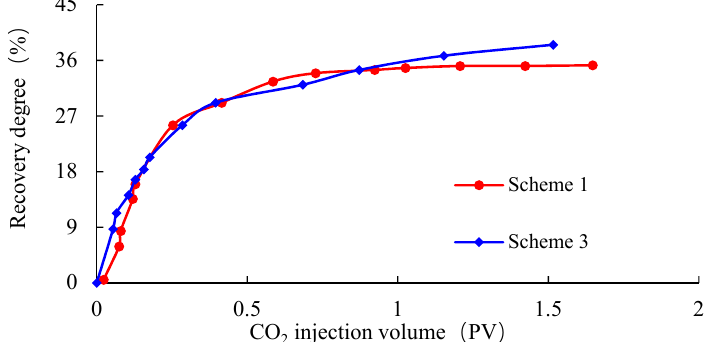
Figure 17. The relationship between CO 2 injected volume and recovery degree (Scheme 1 and Scheme 3).